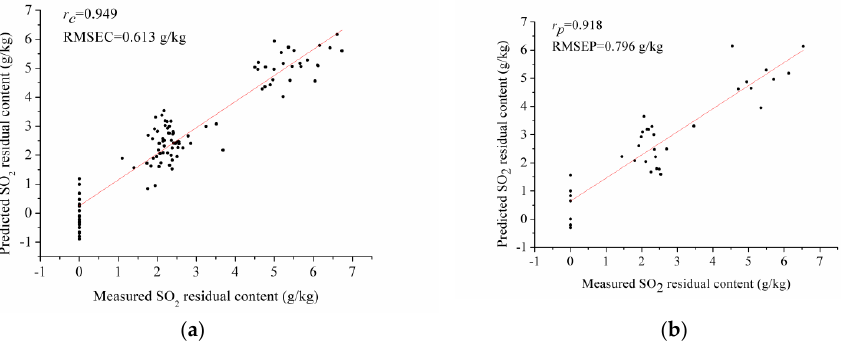
Figure 2. Prediction results of ( a ) the calibration set and ( b ) the prediction set of the PLSR model using the full